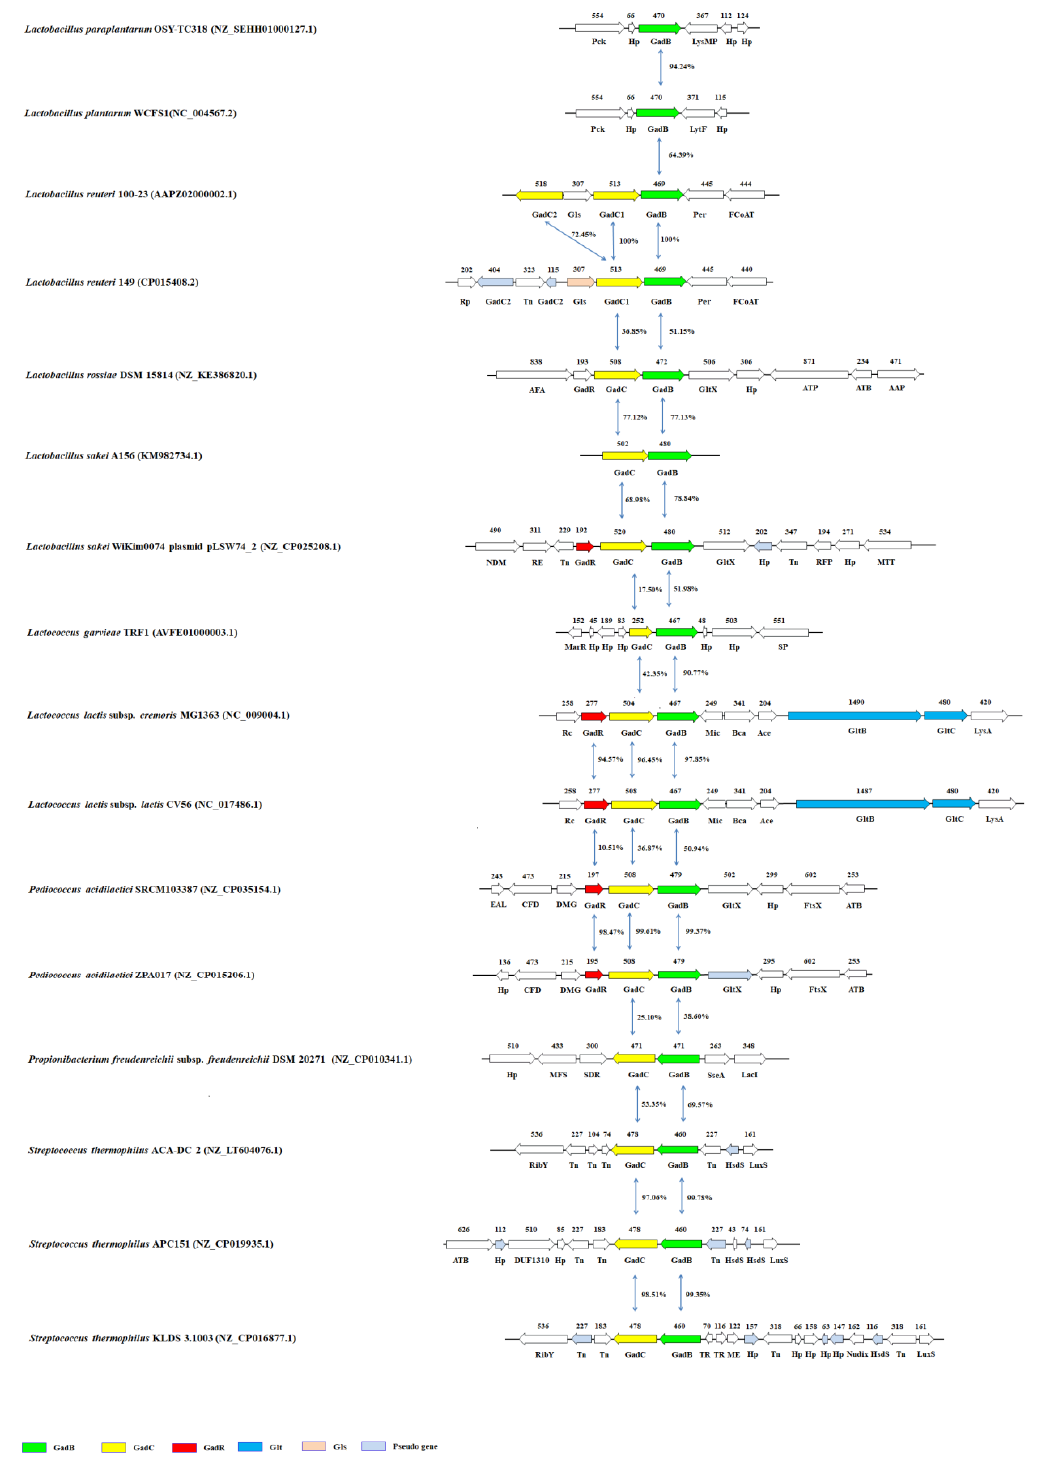
Figure 2. Genetic organization of the glutamate decarboxylase gene clusters among some lactic acid bacteria (LAB) strains. The number of amino acids within each encoded protein is shown above the corresponding protein. AAP, amino acid permease; Ace, sugar O-acetyltransferase; ACR, amino acid racemase; Ade, adenine deaminase; Adh, zinc-dependent alcohol dehydrogenase family protein; AFA, AAA family ATPase; Akr, aldo / keto reductase; Alt, PLP-dependent aminotransferase family protein; At, metN2, ABC transporter, ATP-binding protein; ATB, ABC transporter ATP-binding protein; ATL, aspartate—tRNA ligase; ATP, ABC transporter permease; Bca, branched ‐ chain amino acid aminotransferase; CAL, carboxylate—amine ligase; CFD, C69 family dipeptidase; CrcB, fluoride efflux transporter; Ctp, cobalt ABC transporter, ATP ‐ binding protein; CTR, Crp/Fnr family